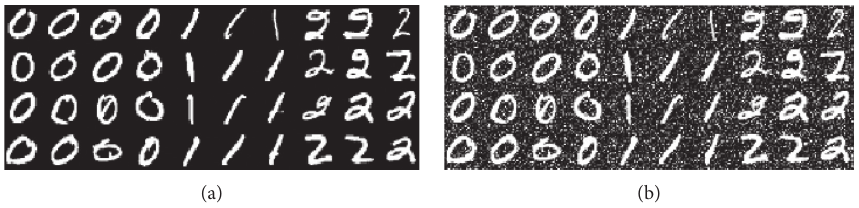
Figure 17: Example of original “0,” “1,” and “2” images and images with noise.